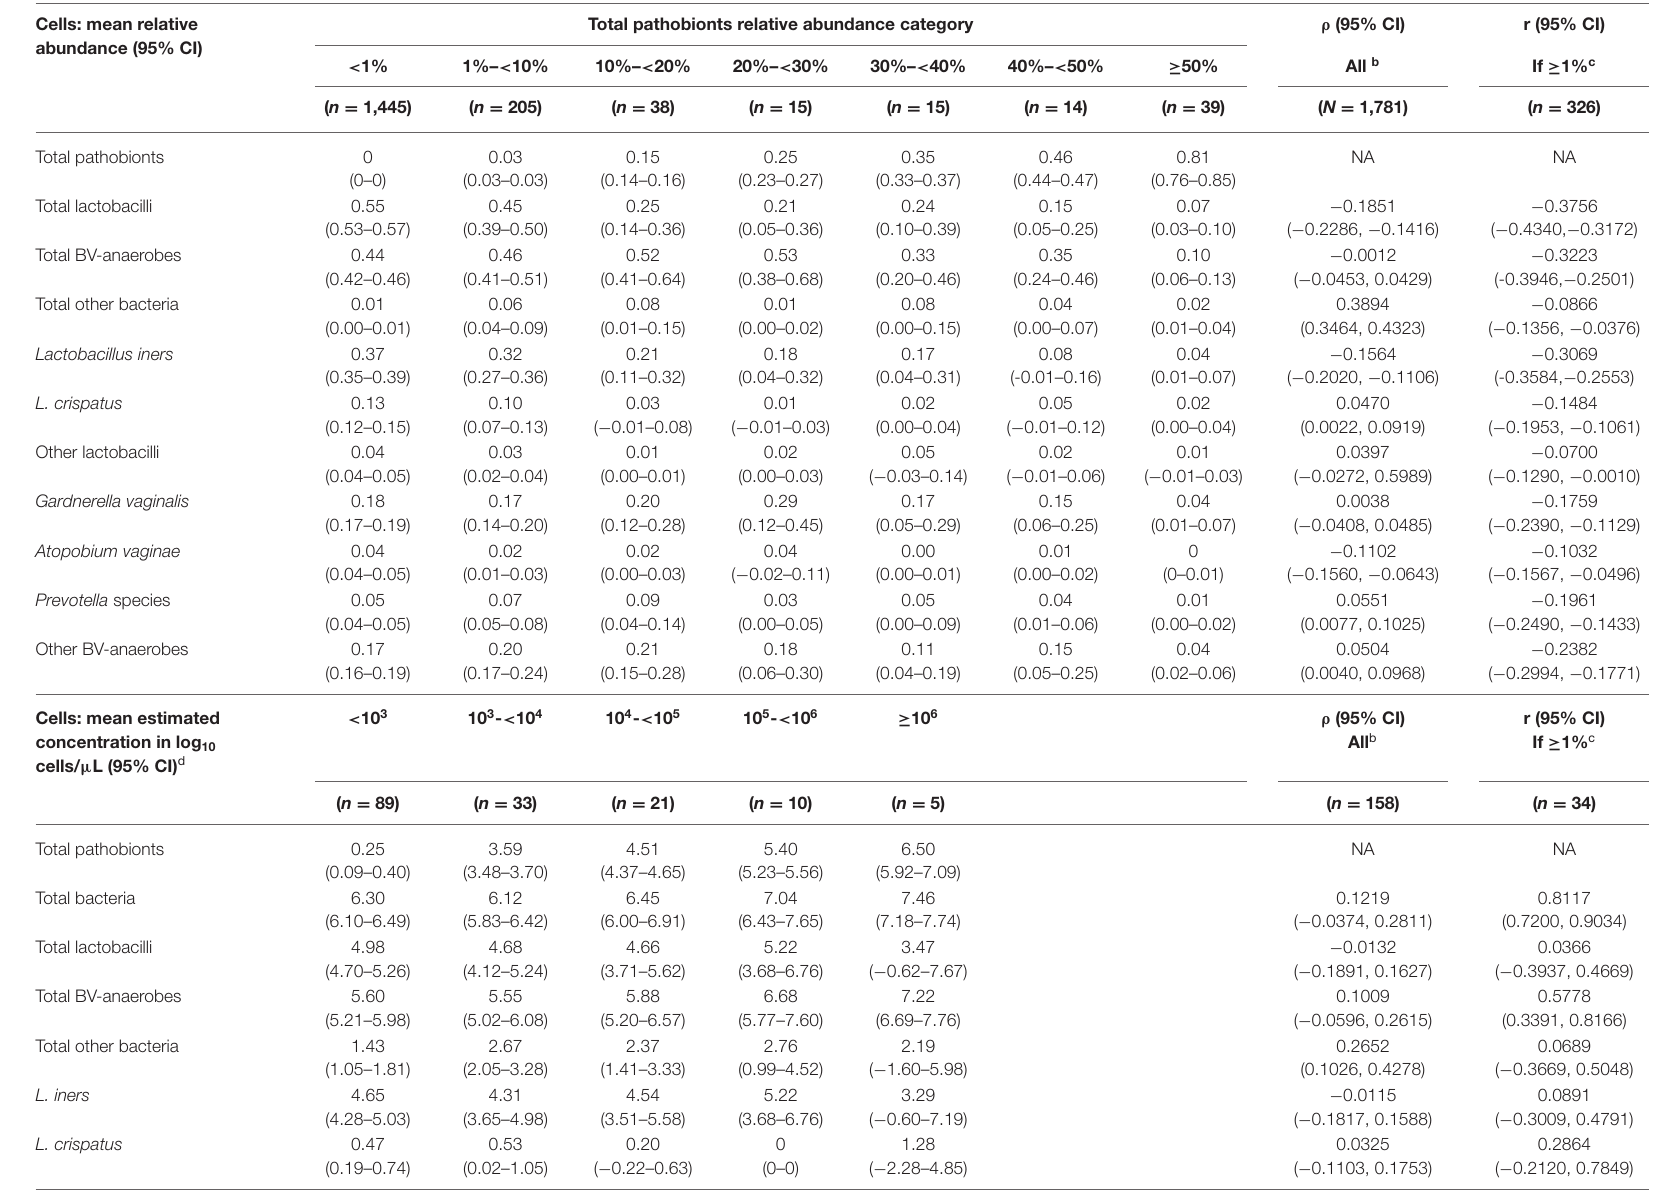
TABLE 5 | VMB correlates by pathobionts relative abundance category, all samples from all studies not influenced by interventions ( N = 1,781) a . Cells: mean relative abundance (95%